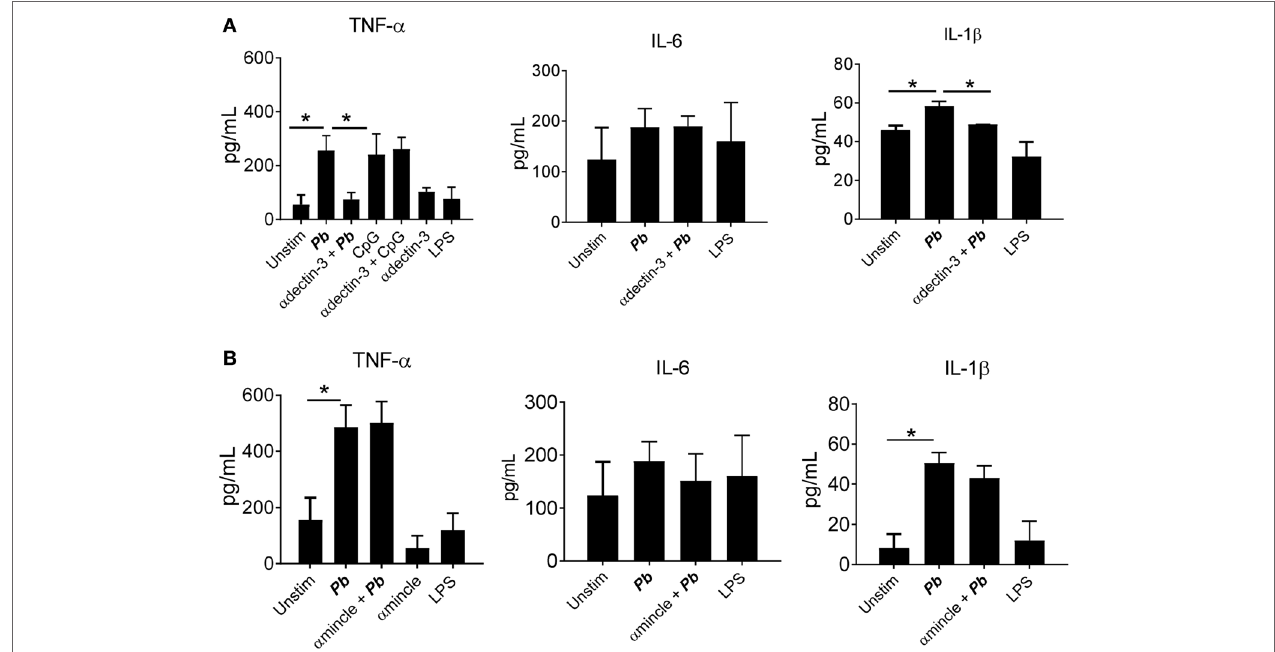
FigUre 7 | Dectin-3, but not mincle, controls cytokine secretion by Paracoccidioides brasiliensis stimulated plasmacytoid dendritic cells (pDCs). Peripheral blood mononuclear cells were separated into pDC-positive populations (pDCs + ) using magnetic beads conjugated to anti-CD304 antibodies. The pDCs (1 × 10 5 /well) were challenged overnight with P. brasiliensis yeast cells (2 × 10 3 ). Some wells were treated only with the yeasts or with LPS (10 ng/mL). Some cultures were treated with (a) anti-mincle (100 µg/mL) or (B) anti-dectin-3 antibody (100 µg/mL). After 18 h of culture, the plates were centrifuged, and the supernatant was collected for cytokine measurements by ELISA. Data are represented as the mean ± SE of the average of cytokine concentrations from four donors, tested in duplicate. *** p < 0.001 and * p < 0.05 comparing the data indicated by the